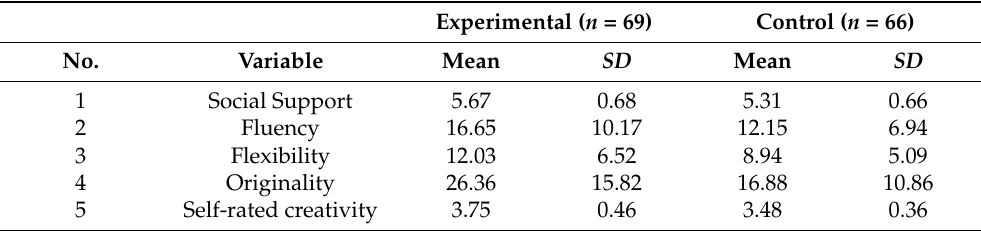
Table 1. Mean and standard deviation of social support and creativity measures in the experimental and control groups. Experimental ( n =